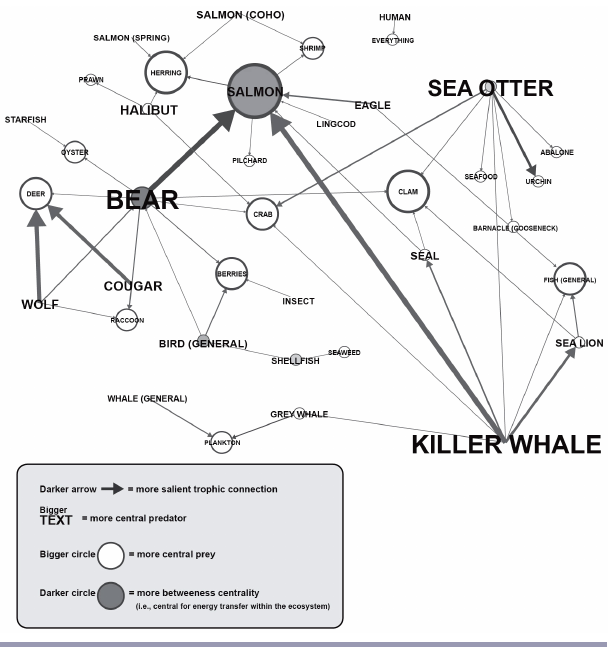
Fig. 3 . Aggregate mental model of the regional food web: males. The feeding habits of large charismatic megafauna (bears, killer whales, cougars, and wolves) tend to dominate males’ aggregate mental model in terms of cognitive accessibility. The prolific feeding habits of sea otters are also recognized but remain relatively less salient (with the slight exception of their consumption of urchins, and to a lesser extent crab). Salmon play the most central role in males’ imagined trophic web: they are both the most important single prey species, as well as being most crucial to the transfer of energy throughout the food web. For men, other prey with particular importance to the wider food web include herring and clams. Humans are recognized as prolific predators, but with very low salience. (Note that this visualization is demonstrative of the method’s potential uses, not necessarily representative of a demographic with statistically distinct